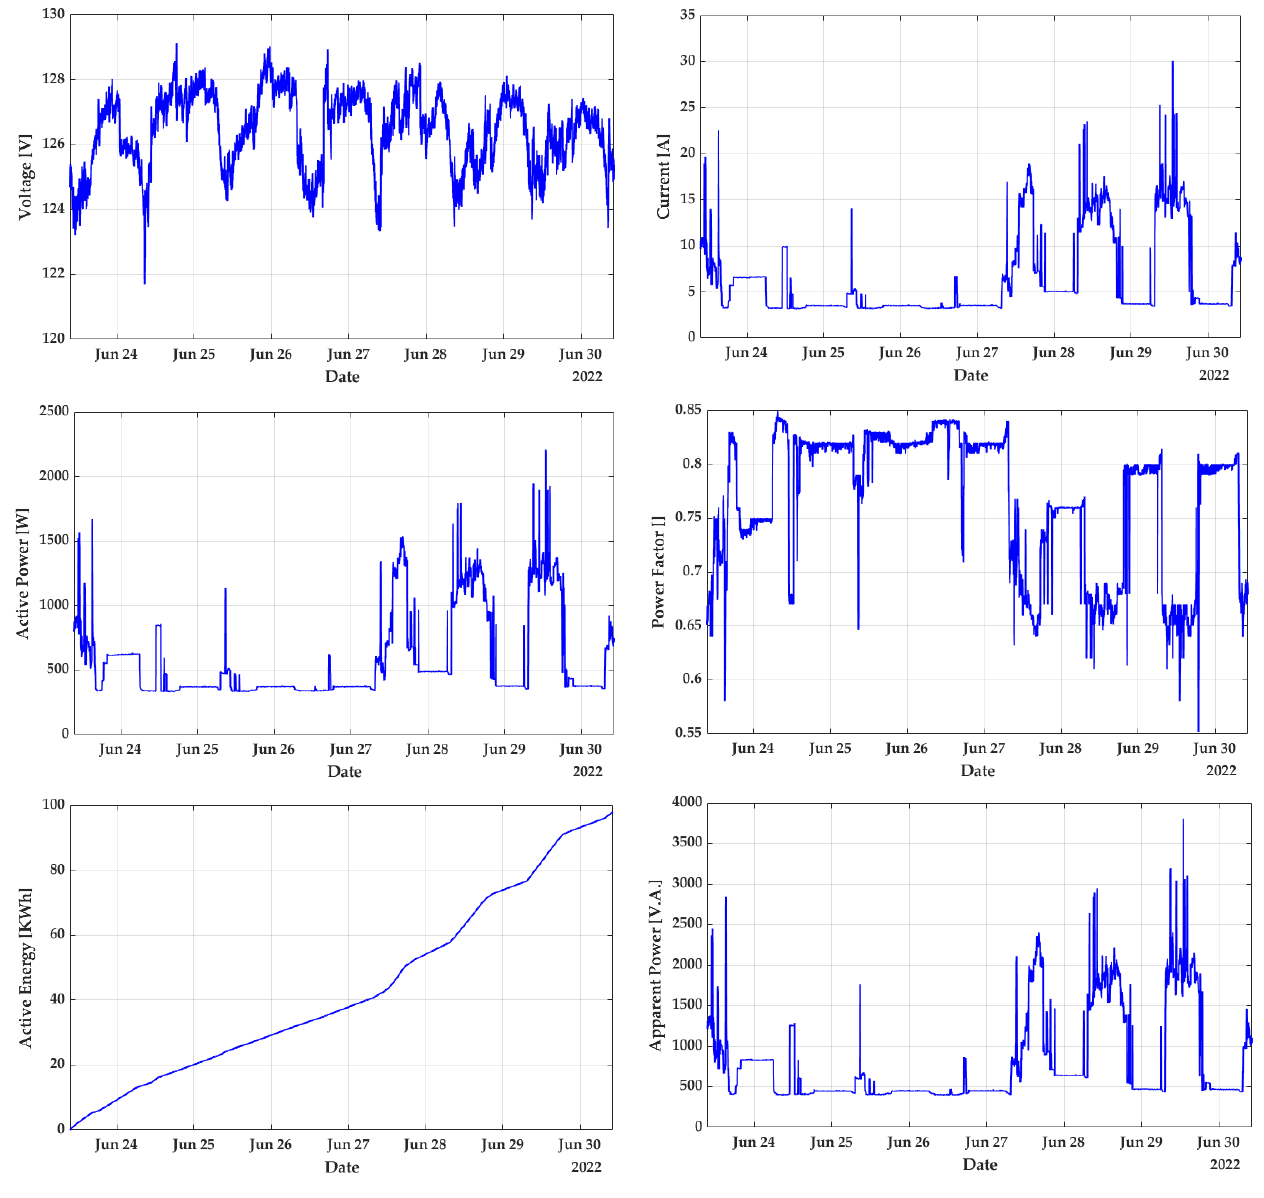
Figure 15. Measurements of electrical parameters obtained by Sensor 2 of the proposed system during the dates of 23 June and 30 June 2022.